Question: What kind of plot is shown here?
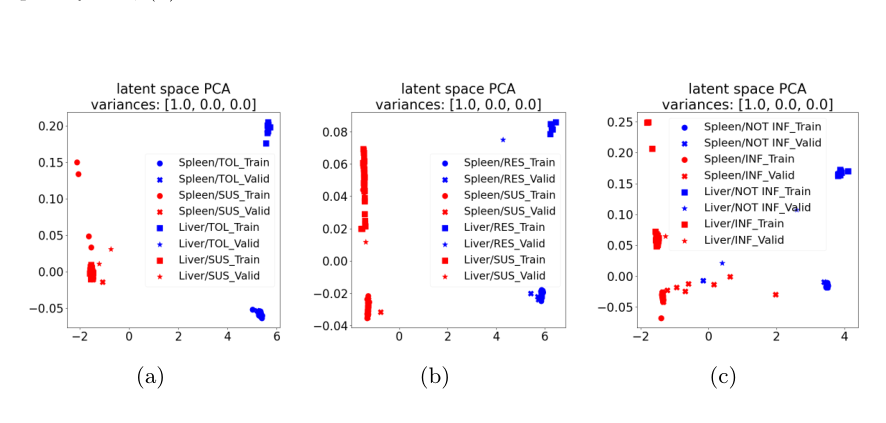
Answer: scatter